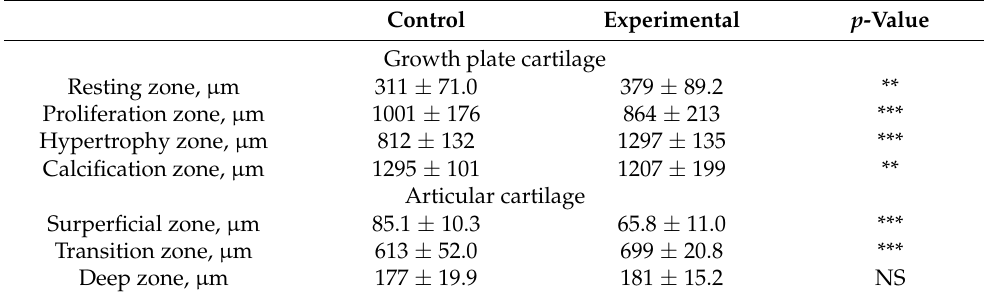
Table 3. The effect of C. perfringens infection on growth plate and articular cartilage histomorphology of the tibia in examined animals at the age of 42 days.